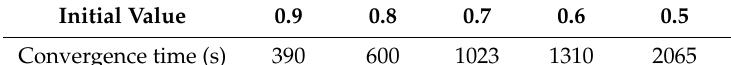
Figure 18. ( a ) The comparison of the convergence performance of SoC estimation between di ff erent initial value of SoC using IAUKF-UKF under DST test; ( b ) The comparison of the convergence performance of u L prediction between di ff erent initial value of SoC using IAUKF-UKF under DST test. Table 6. Convergence time of di ff erent initial SoC under DST test.